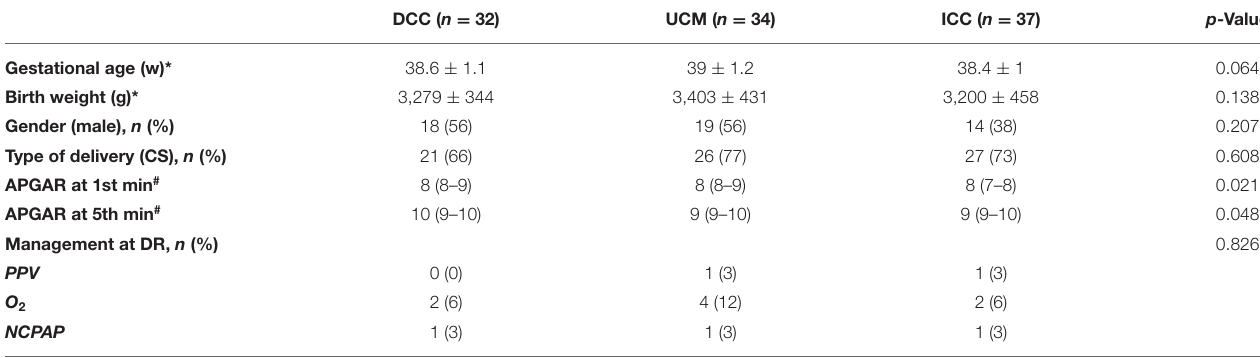
TABLE 1 | The demographic findings of the infants included in the study groups.